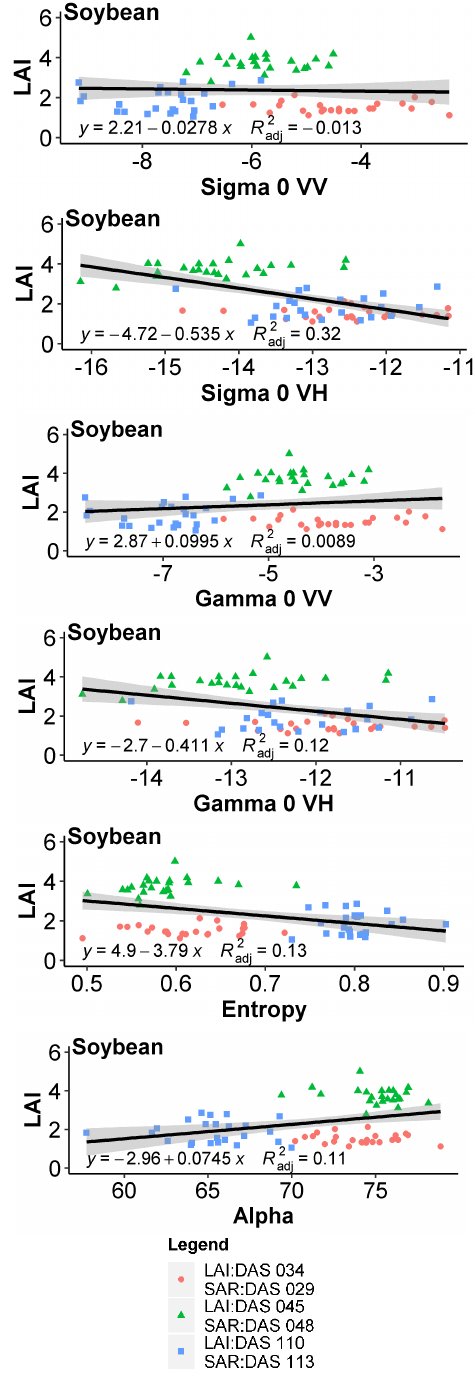
Figure 8. Relationship between LAI and Sigma, Gamma, Entropy and Alpha angle for